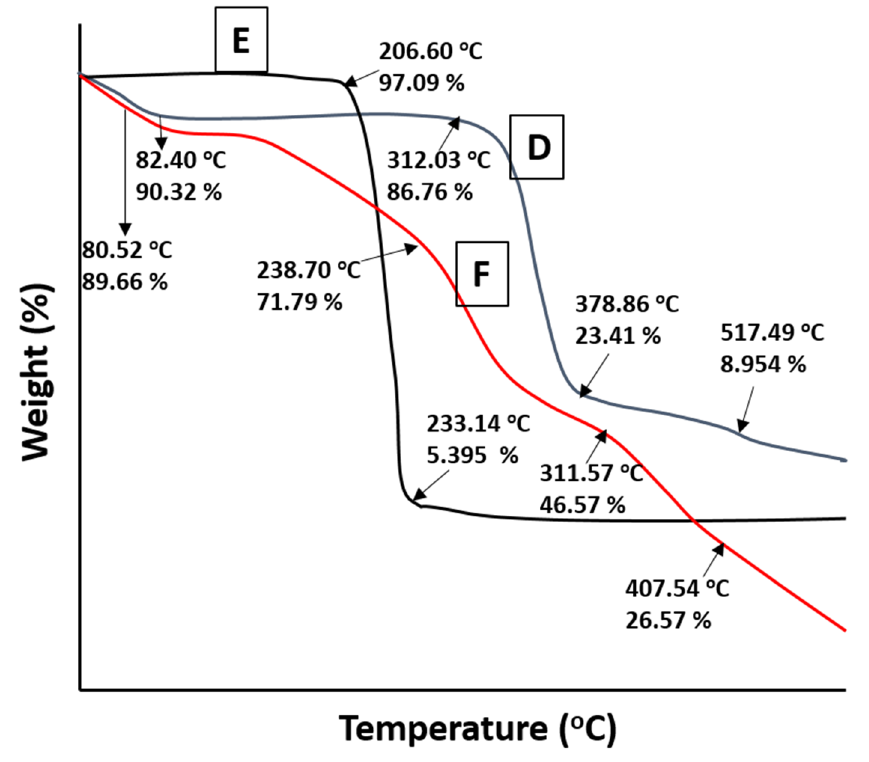
Figure 6. TGA thermograms of HP β CD ( D ), Cytarabine ( E ) and Cytarabine-loaded hydrogels ( F